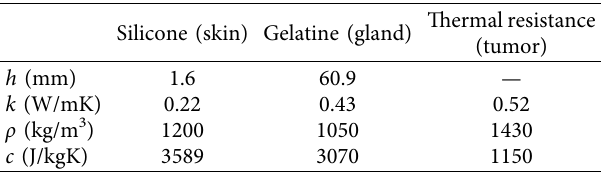
Figure 4: Block diagram of the confguration of the noninvasive measurement system. Table 2: Physical and geometric characteristics of the simplifed breast model